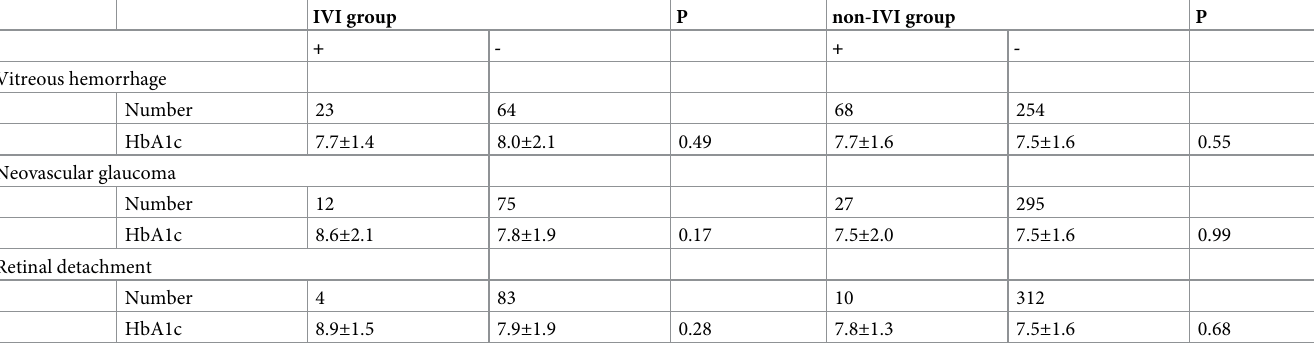
Table 4. Comparison of baseline HbA1c in eyes with and those without postoperative